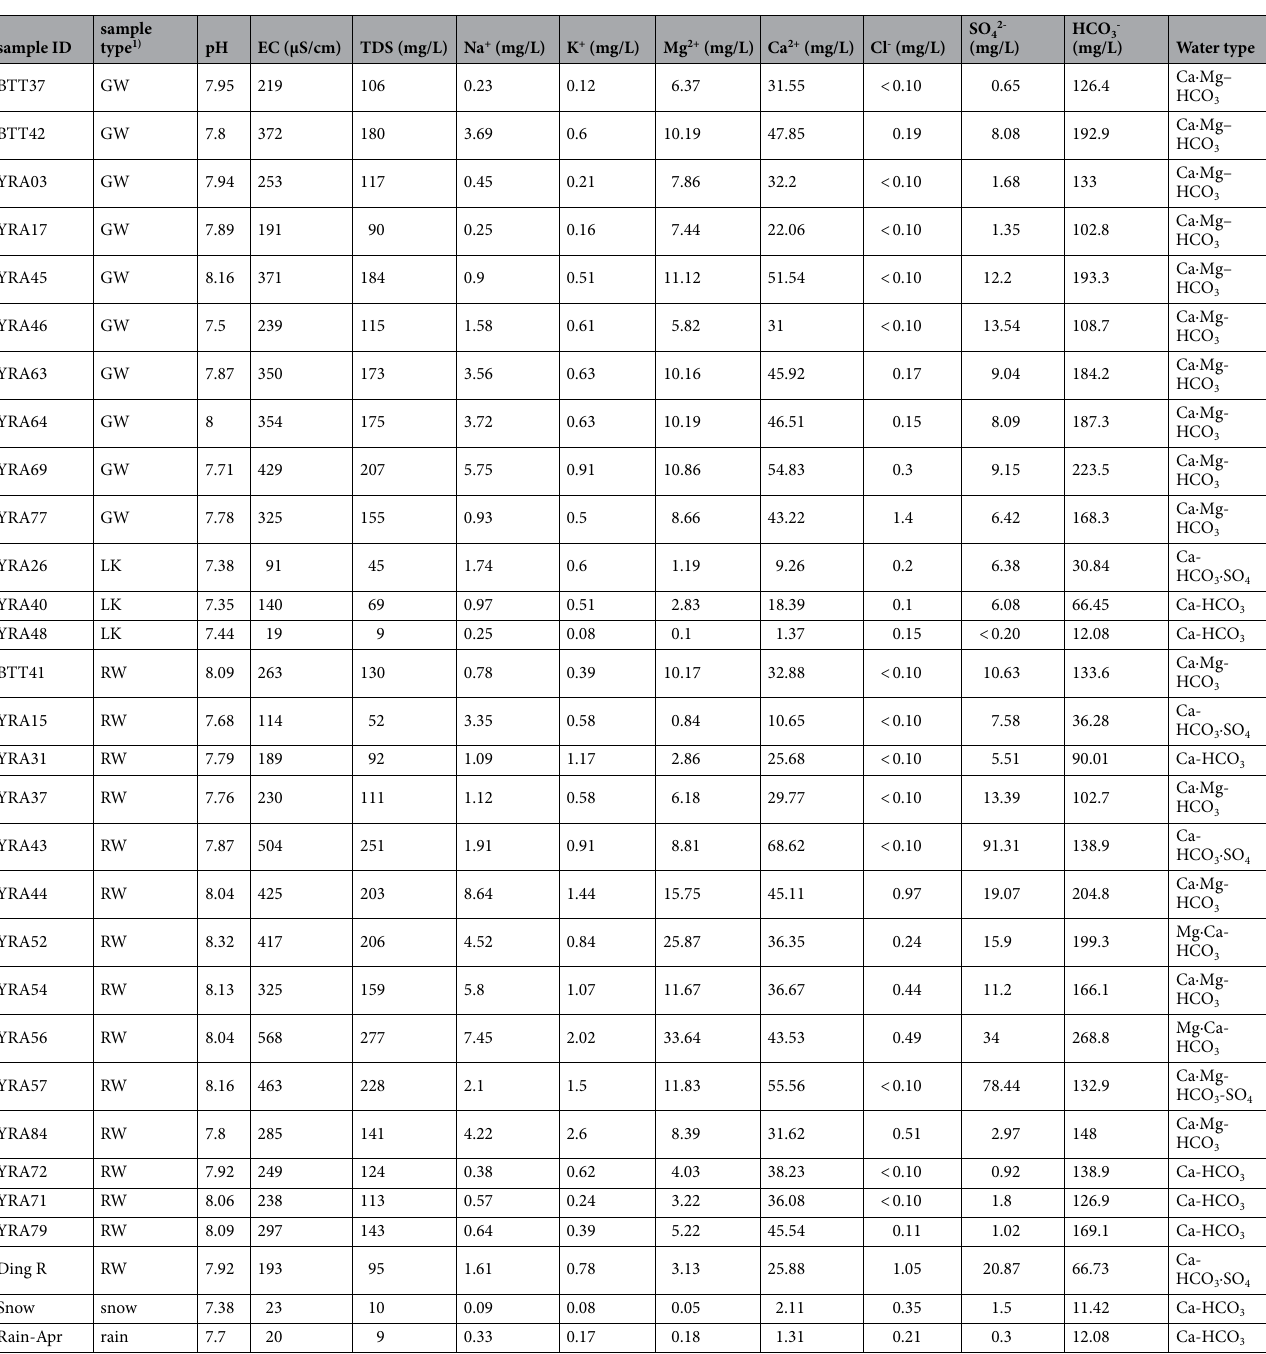
Table 2. Hydrochemical types and major ion concentrations of samples from within the study area. 1) Sample type, GW—groundwater, LK—lake, RW-river